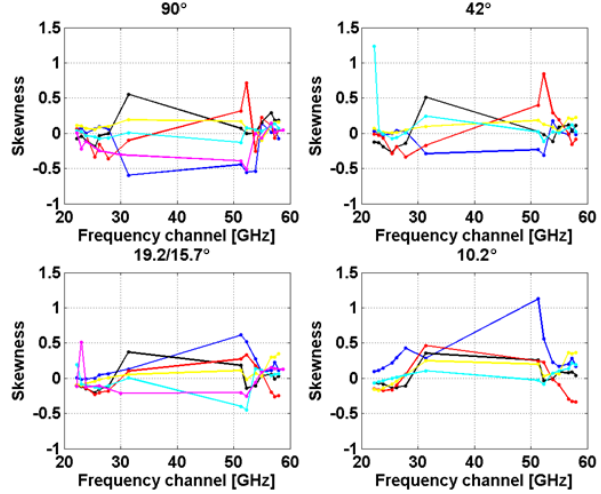
Figure 9. Skewness as function of frequency for elevation angles 90.0, 42.0, 19.2 (15.7 for RAO), and 10.2 ◦ . Scores for JOYCE, LACROS, Payerne, SIRTA, CESAR, and RAO are reported, respec- tively, in blue, black, red, yellow, cyan, and